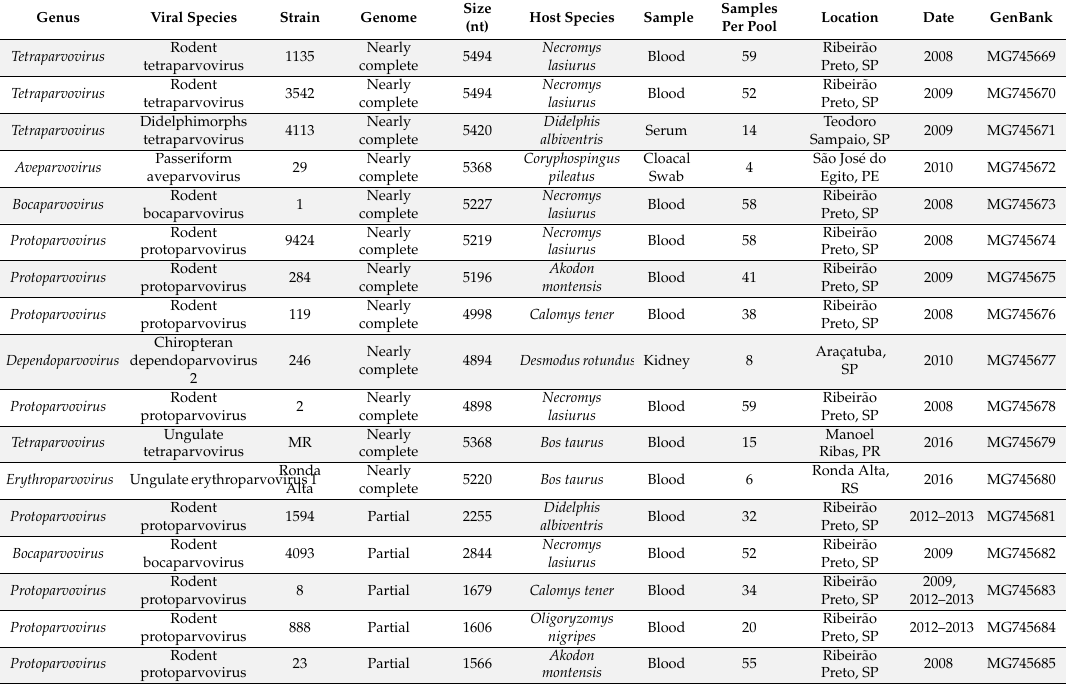
Table 1. Sequences information, sources, sample, location, location, date and environment of viruses identified in wild animals from